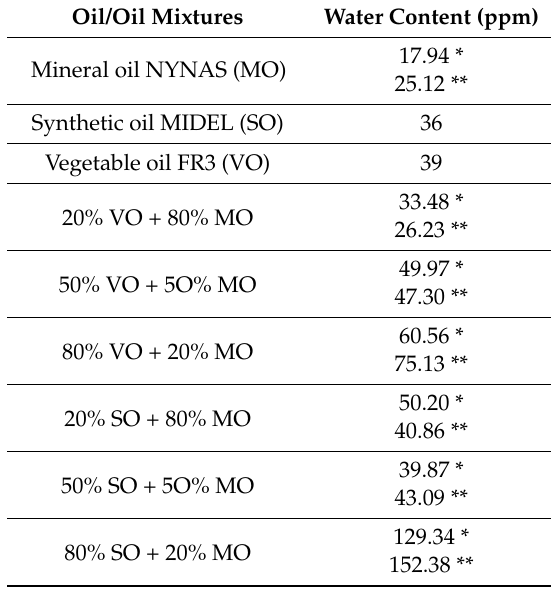
Table 2. Water contents of oils and oil mixtures before testing at ambient: (*) in AC and (**) in